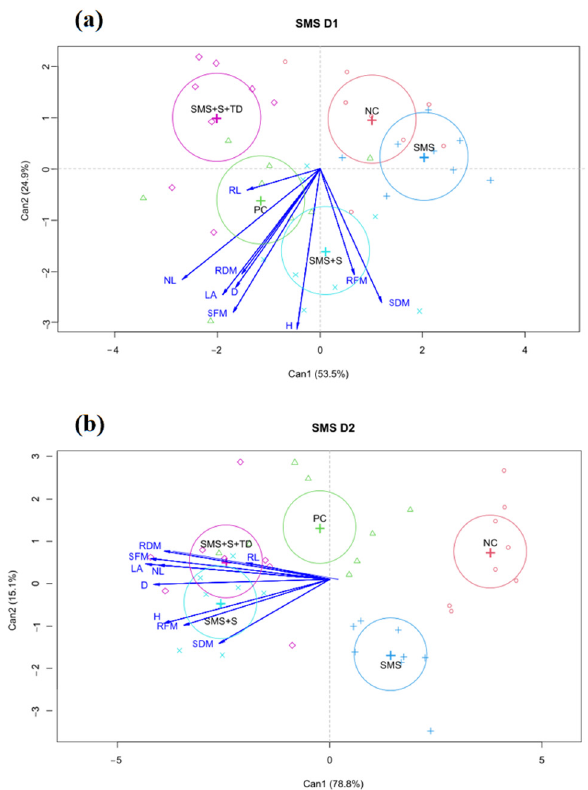
Figure 3. Canonical discriminant analysis (CDA) of 70 DAS maize plants cultivated under different types of SMS management at two different doses. ( a ) Analysis under the SMS Dose 1 condition and ( b ) the condition of double the previous condition—SMS Dose 2. NC: negative control, PC: positive control, SMS: residue application only, SMS + S: SMS application with sowing fertilization, SMS + S + TD: SMS application with sowing and topdressing fertilization.